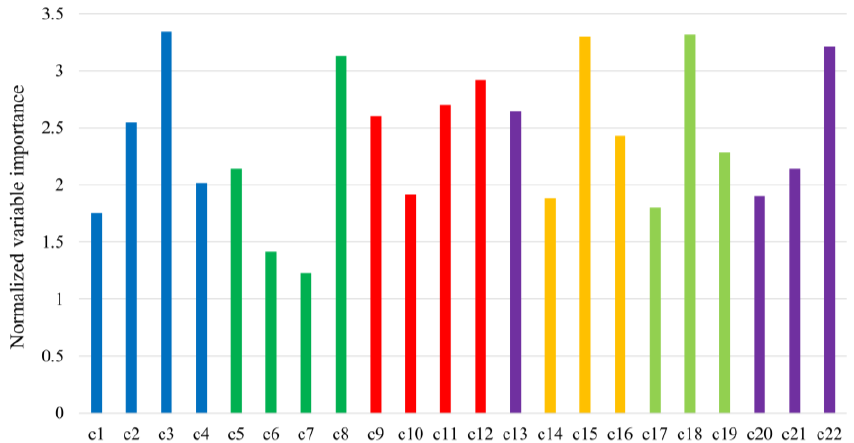
Figure 7. Normalized RF variable importance for extracted features from the simulated CP SAR data (July 21). Please note that c1 : 𝜎 𝑅𝐻0 , c2 : 𝜎 𝑅𝑉0 , c3 : 𝜎 𝑅𝑅0 , c4 : 𝜎 𝑅𝐿0 , c5 : 𝑆 0 , c6 : 𝑆 1 , c7 : 𝑆 2 , c8 : 𝑆 3 , c9 : 𝜇 𝑐 , c10